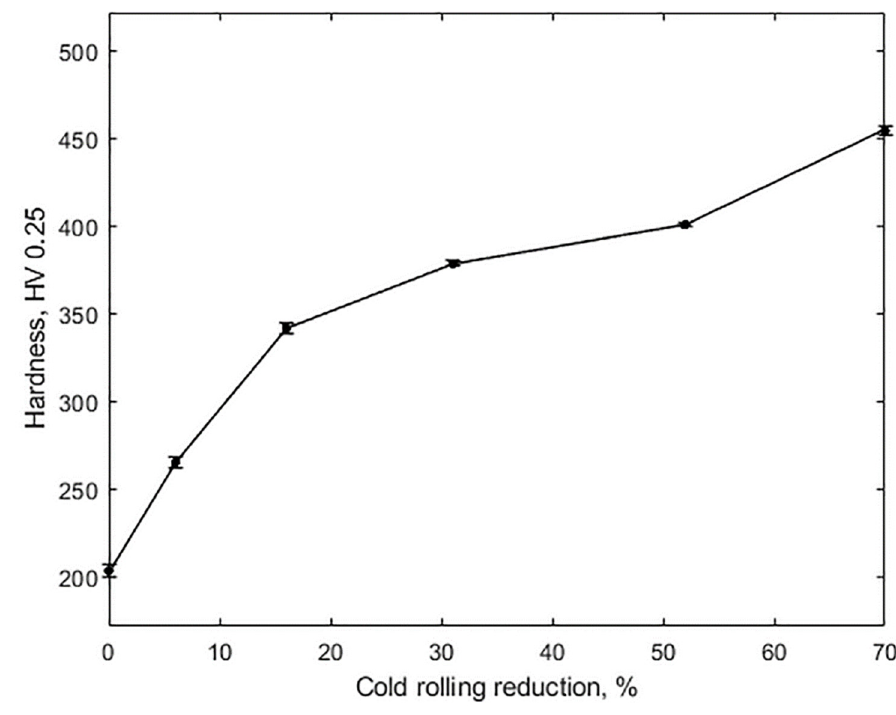
Figure 3. Hardness vs. thickness reduction by cold rolling.